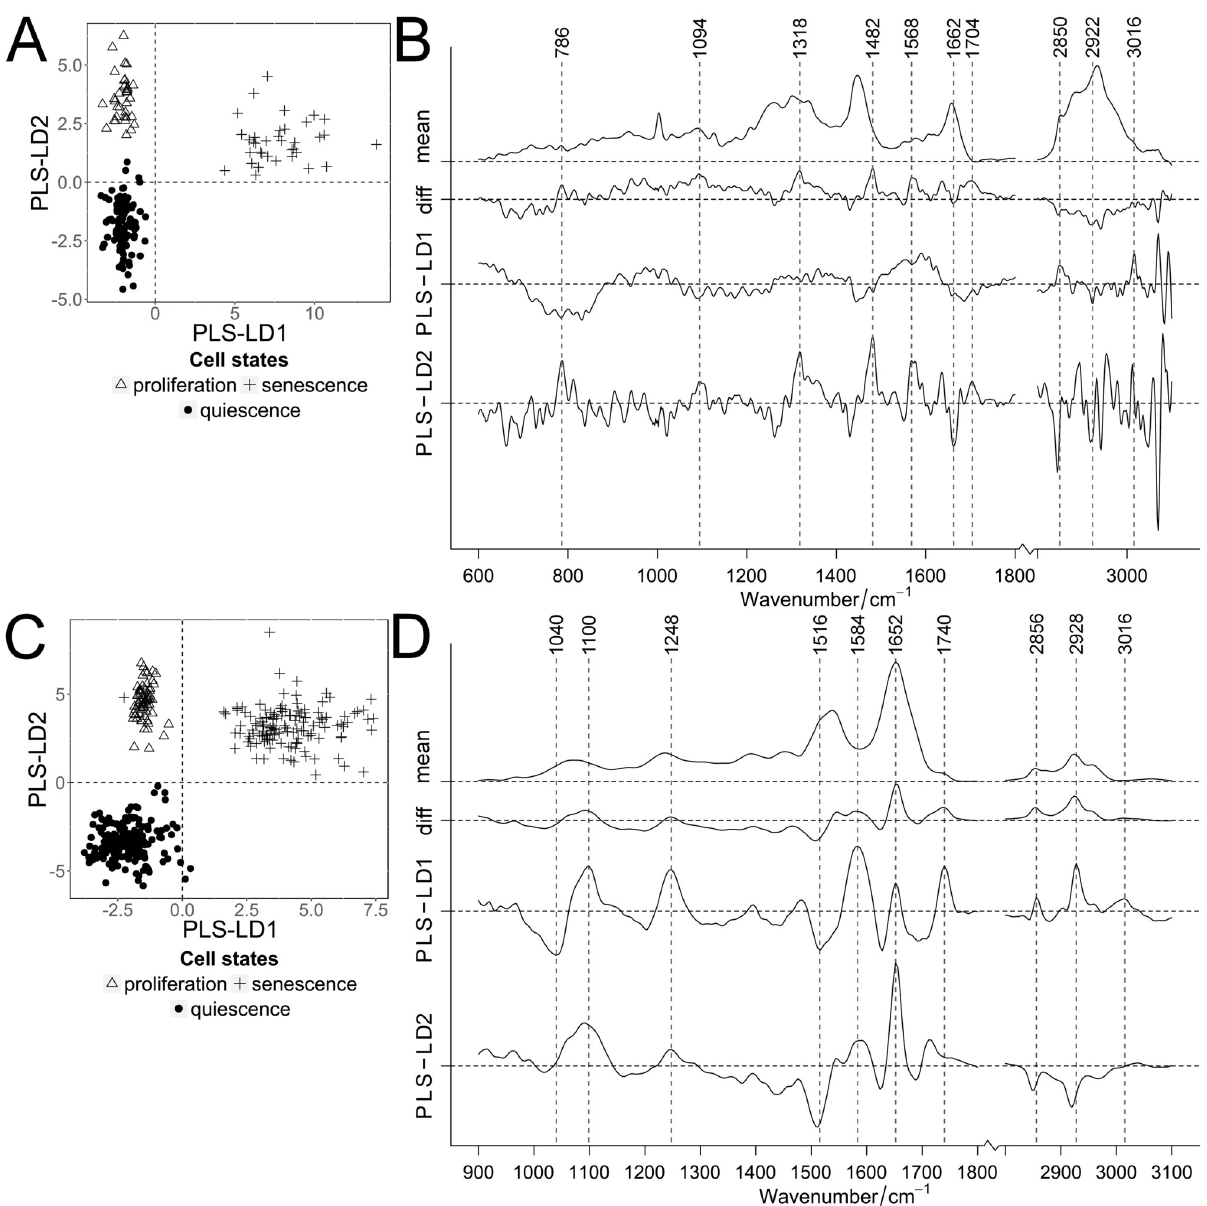
Fig 5. Classification of the 3 cell states: Proliferation, quiescence and senescence. PLS-LDA of Raman (A, B) and FT-IR spectra (C, D) of proliferating, quiescent and senescent cells. Scatter plots (A, C) of cell states: proliferation (triangle), senescence (plus) and quiescence (black dots, 100 days long-term cultivation by contact inhibition). Mean and difference spectra (“diff”, (B) proliferation vs. quiescence and (D) senescence vs. quiescence) from the classified cells are plotted together with the PLS-LD1 and -LD2 coefficients vs. the wavenumber (B, D). observed in the high wavenumber regions (RS: 2850 and 2922 cm -1 ; FT-IR: 1436, 2856 and 2928 cm -1 ). Raman intensity ratios of protein bands (1652 cm -1 , amide I) to lipids (1454 cm -1 ) and the differences within DNA and RNA (782 cm -1 ) were displayed for the different cell states (S7A and S7B Fig). Clear differences between contact inhibited quiescent and senescent cells were detected, the latter showing higher protein/lipid and lower nucleic acid contents. Prolif- erating cells had content values closer to quiescent cells. Senescent cells showed the lowest